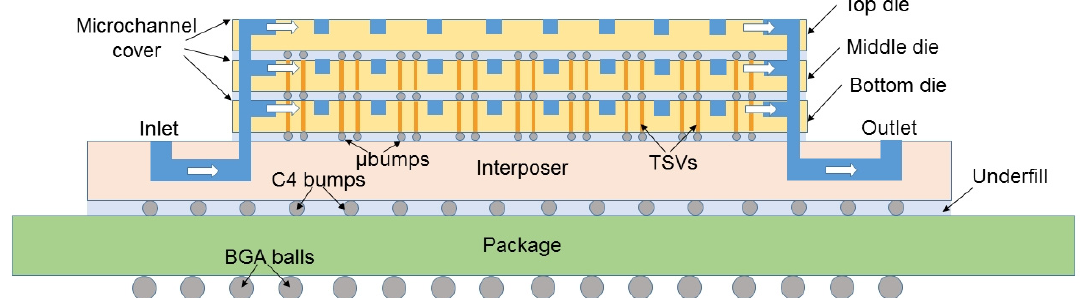
Figure 1. Sample 3D IC with three dies cooled by microchannels. The fluid is inserted into the dies through the interposer.